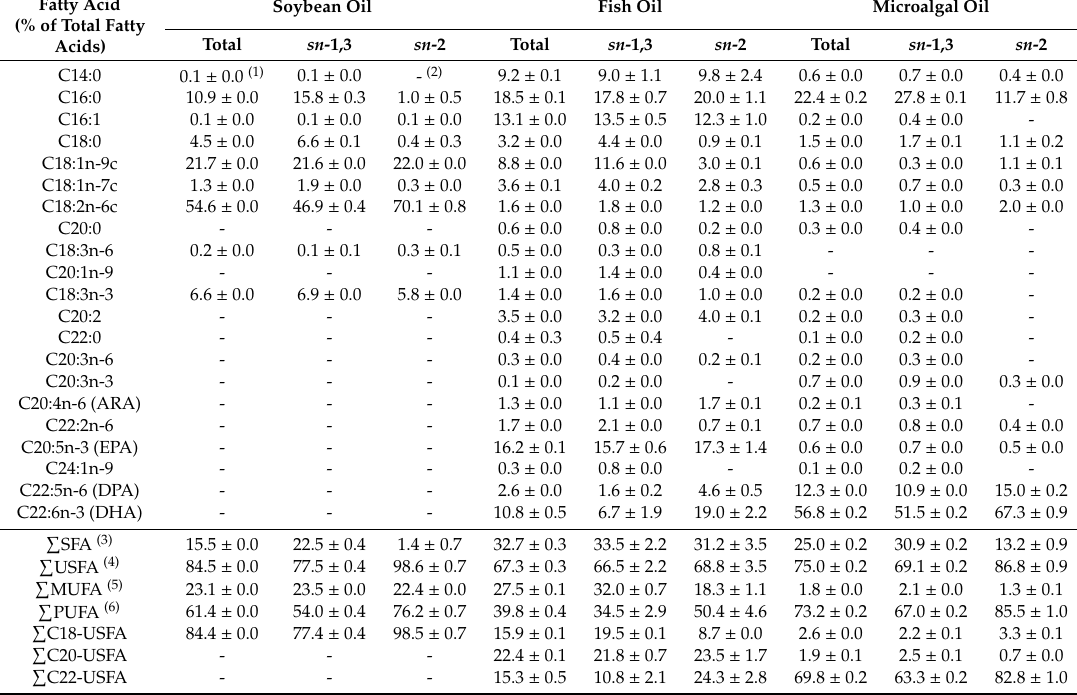
Table 1. Fatty acids compositions of soybean oil, fish oil, and microalgal